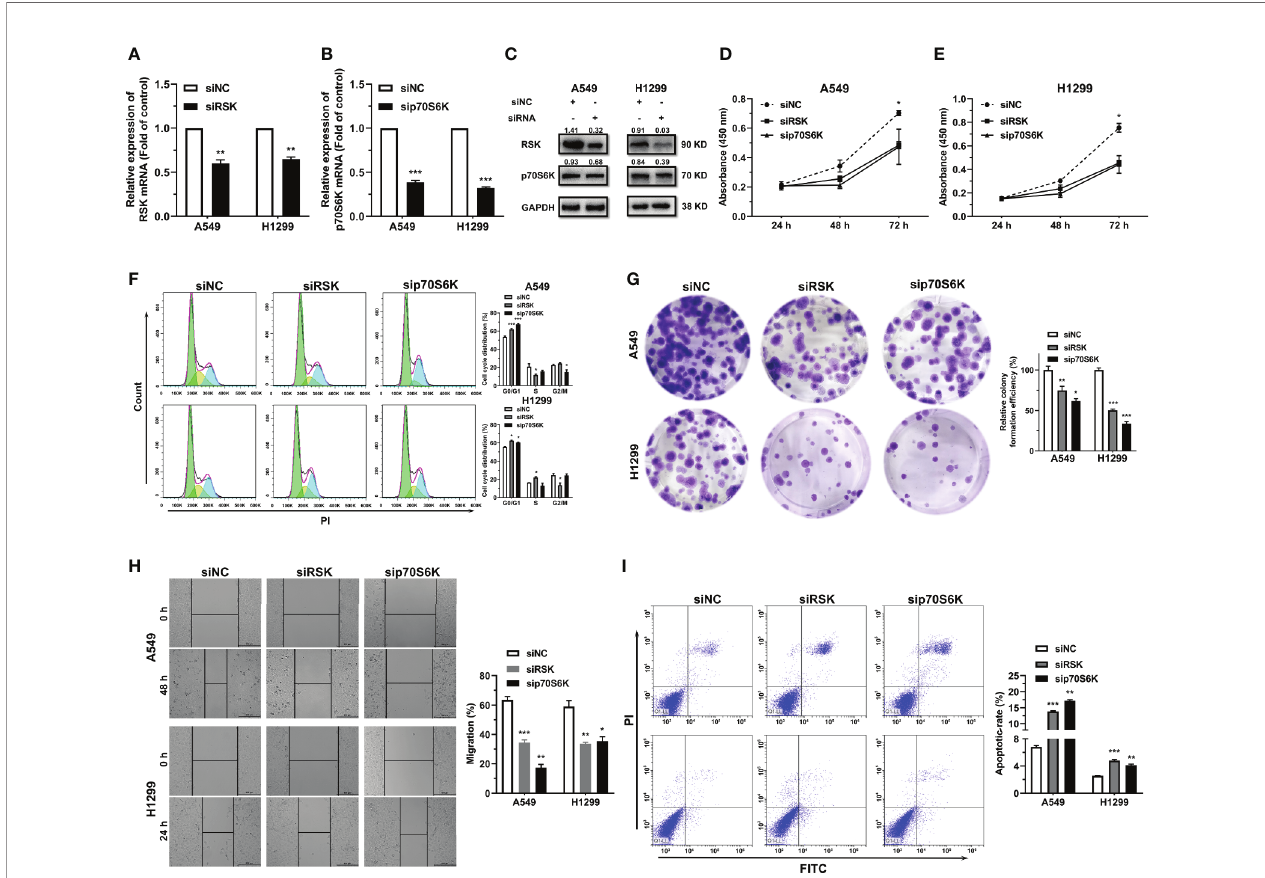
FIGURE 4 | siRSK and sip70S6K suppress NSCLC cell proliferation and promote cell apoptosis. (A, B) RNA expression of RSK/p70S6K in siRSK/sip70S6K transfected A549 and H1299 cells compared to siNC transfected ones. **p < 0.01; ***p < 0.001. (C) The protein expression of RSK/p70S6K in siRSK/sip70S6K transfected A549 and H1299 cells. (D – I) The effect of siRSK/sip70S6K on the proliferation (D, E) , cell cycle progress (F) , colony formation (G) , migration (H) and cell apoptosis (I) of A549 and H1299 cells. *p < 0.05; **p < 0.01; ***p <